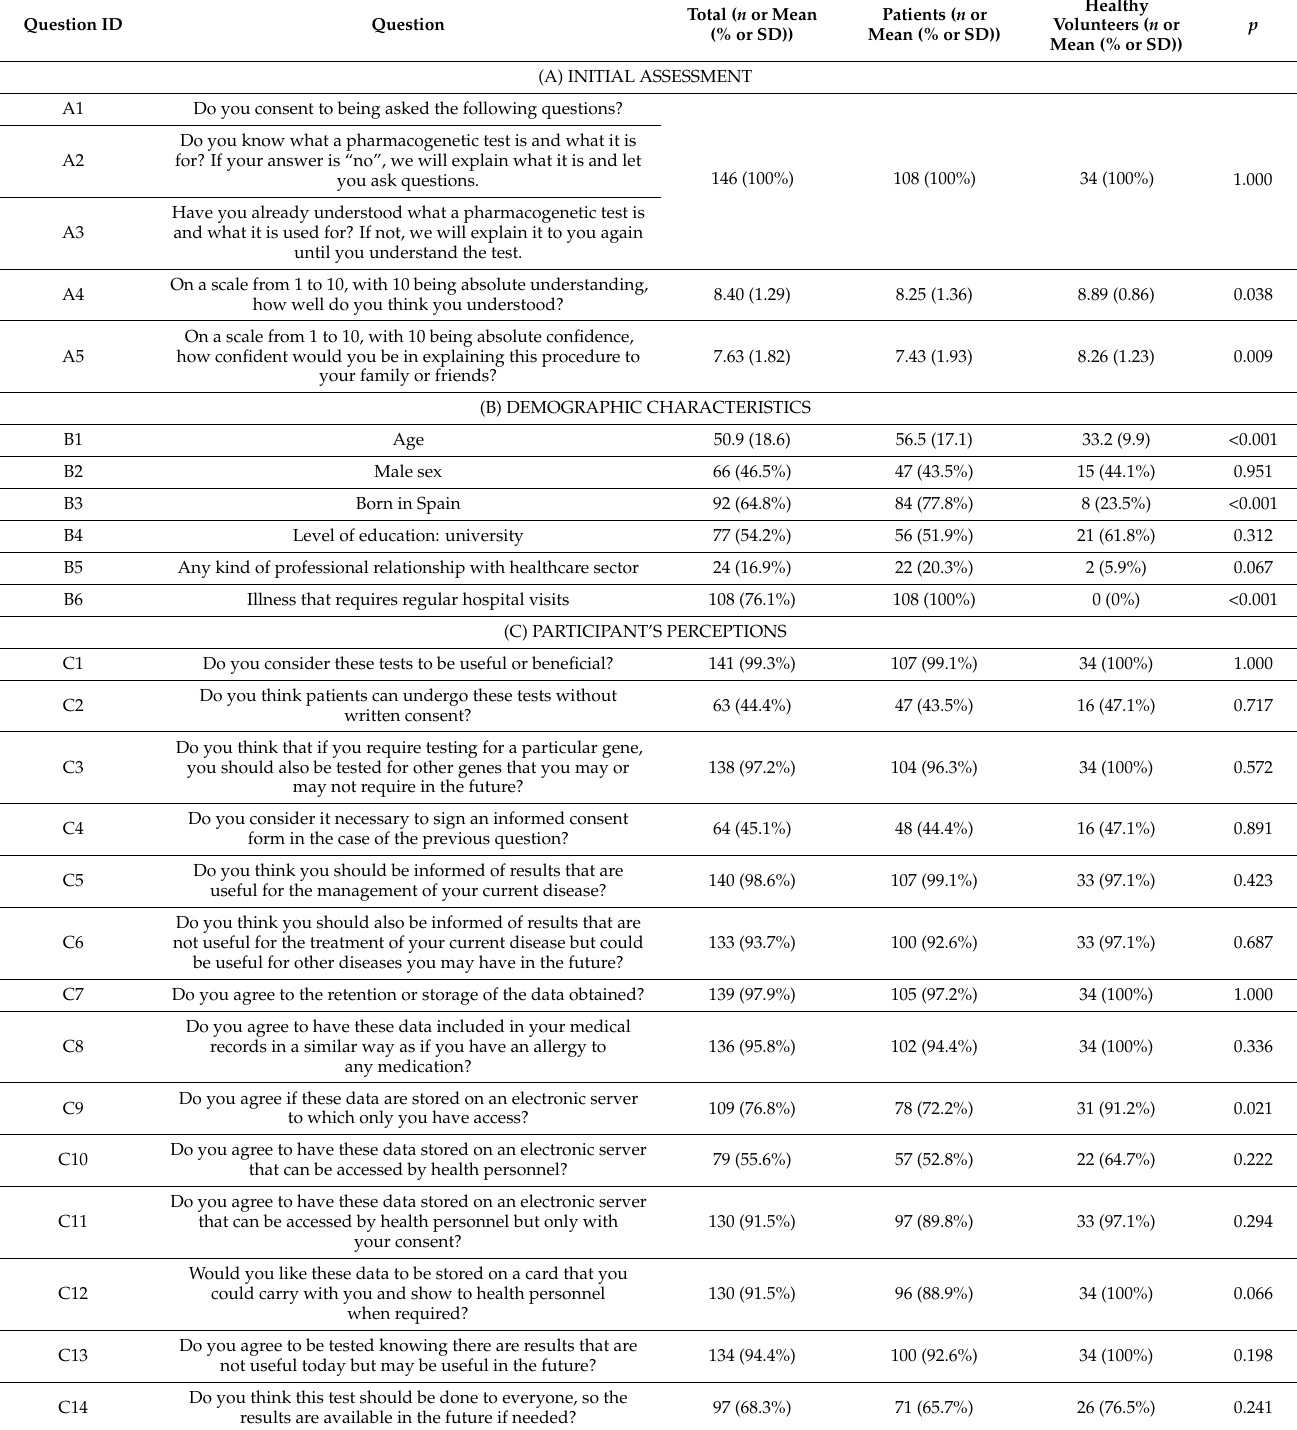
Table 1. Results of the